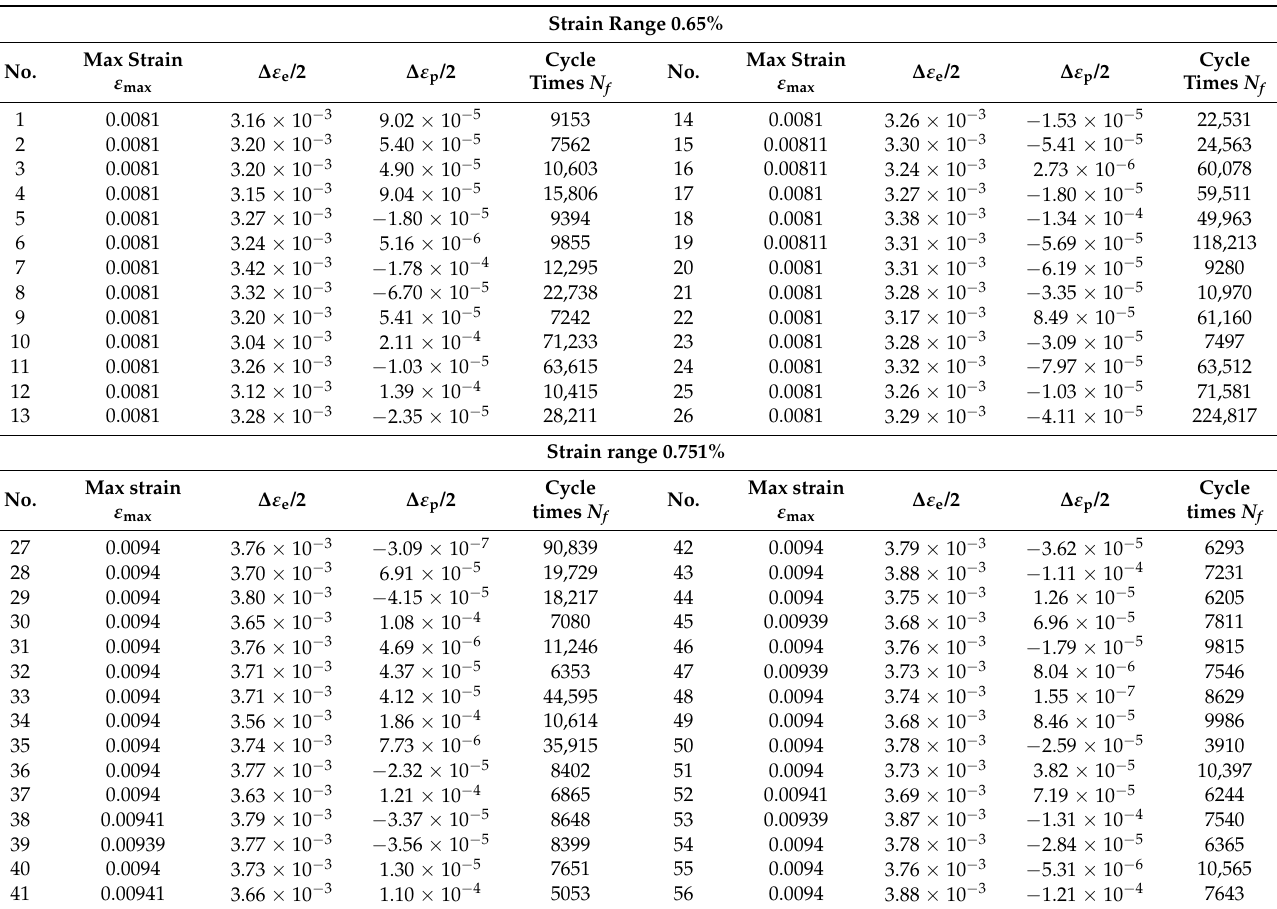
Table A2. Experimental strain amplitude data at T = 600 ◦ C, R =